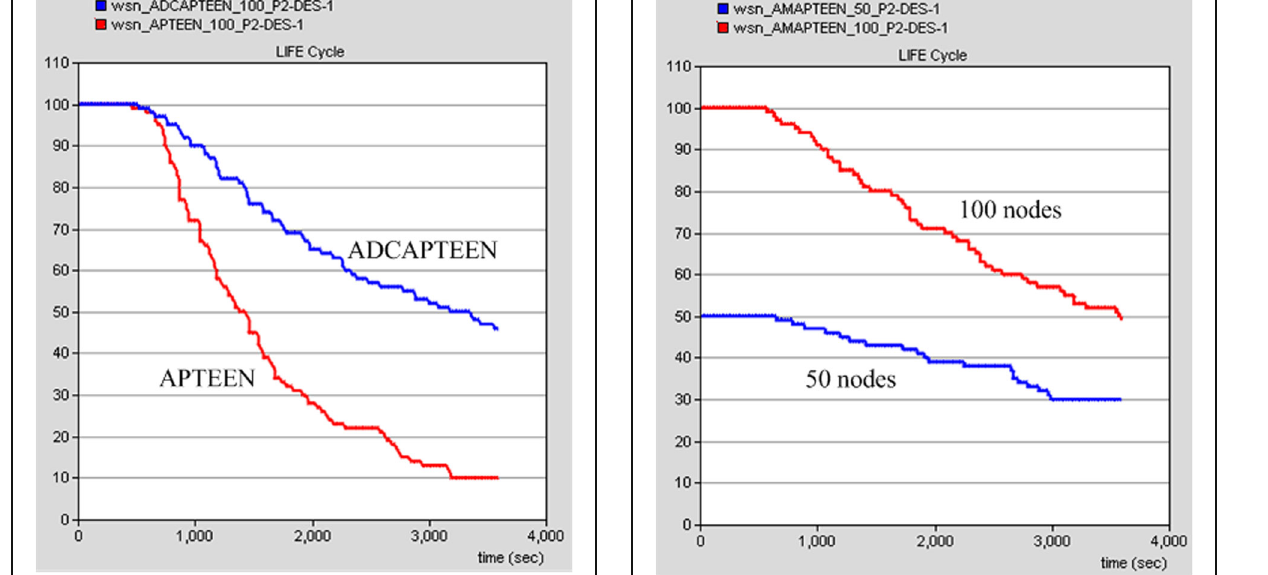
Fig. 14 The life cycle comparison of AMAPTEEN in different scales. The network life cycle of AMAPTEEN compared 100 nodes with the 50-node network topology is shown in this